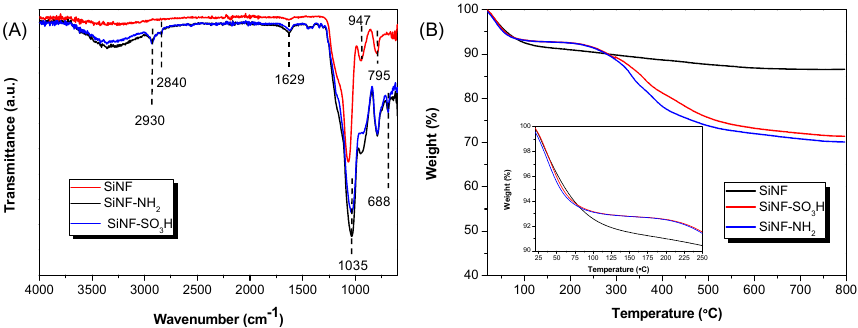
Figure 3. ( A ) ATR-FTIR spectra and ( B ) thermal stability of silica nanofiber